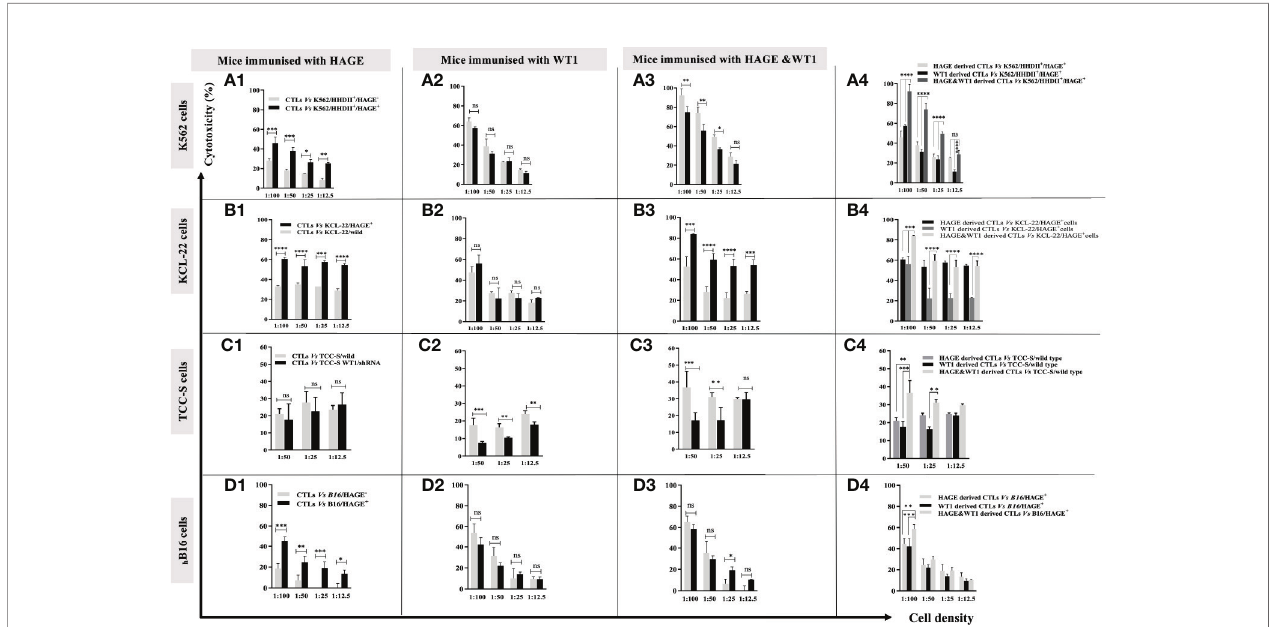
FIGURE 4 | Speci fi c in vitro killing of target cells by vaccine induced CTLs, as assessed by 51Cr release assay. Splenocytes from mice immunised with HAGE, WT1 and combined, were co-cultured in vitro with mitomycin-C treated and peptide-pulsed LPS T cells for 6 days and then plated with 51 Cr labelled-targets at various ratios for 24 hours at 37°C, followed by measuring 51 Cr in the medium. Values are expressed as the mean ± SD of three independent experiments (3 mice/group) and the level of differences between groups were assessed using Two Way ANOVA followed by Tukey ’ s multiple comparisons test. Results demonstrate that the percentage of lysis generated from combined vaccine is higher than the individual vaccines. P*-value < 0.05, **p-value < 0.01, ***p-value < 0.001, ****P-value < 0.0001 versus the corresponding control group. NS, not signi fi